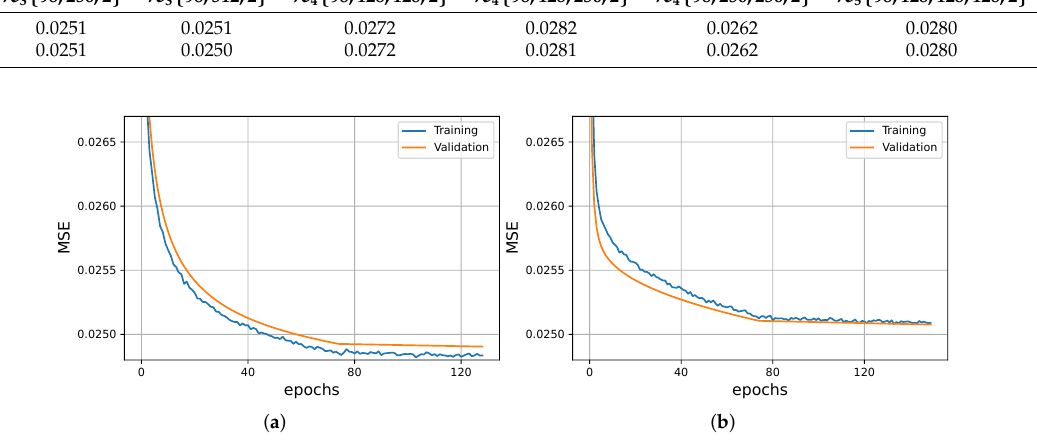
Figure 4. Training (blue) and validation (orange) curves of R 3 { 98,128,2 } and R 3 { 98,256,2 } . ( a ) R 3 { 98,128,2 } . ( b ) R 3 { 98,256,2 }